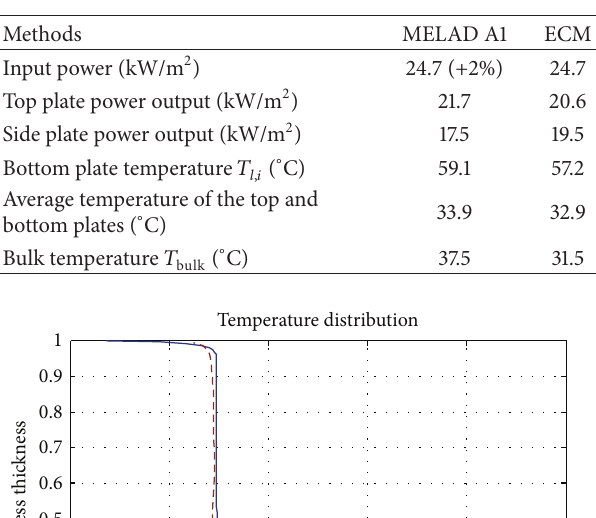
Figure 9: ECM predicted versus DNS [34] temperature profiles across the layer.